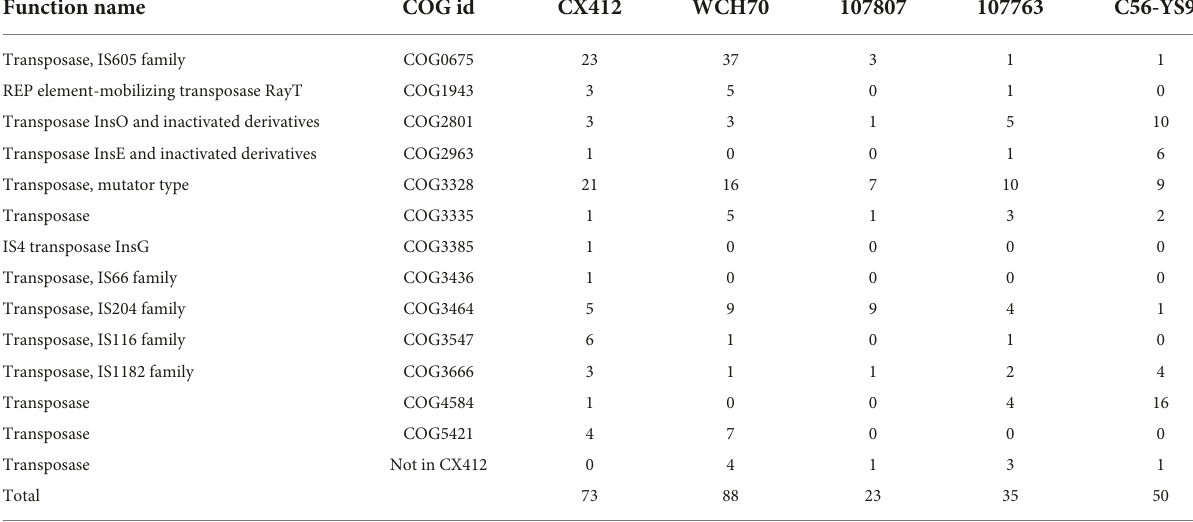
TABLE 4 Comparison of predicted